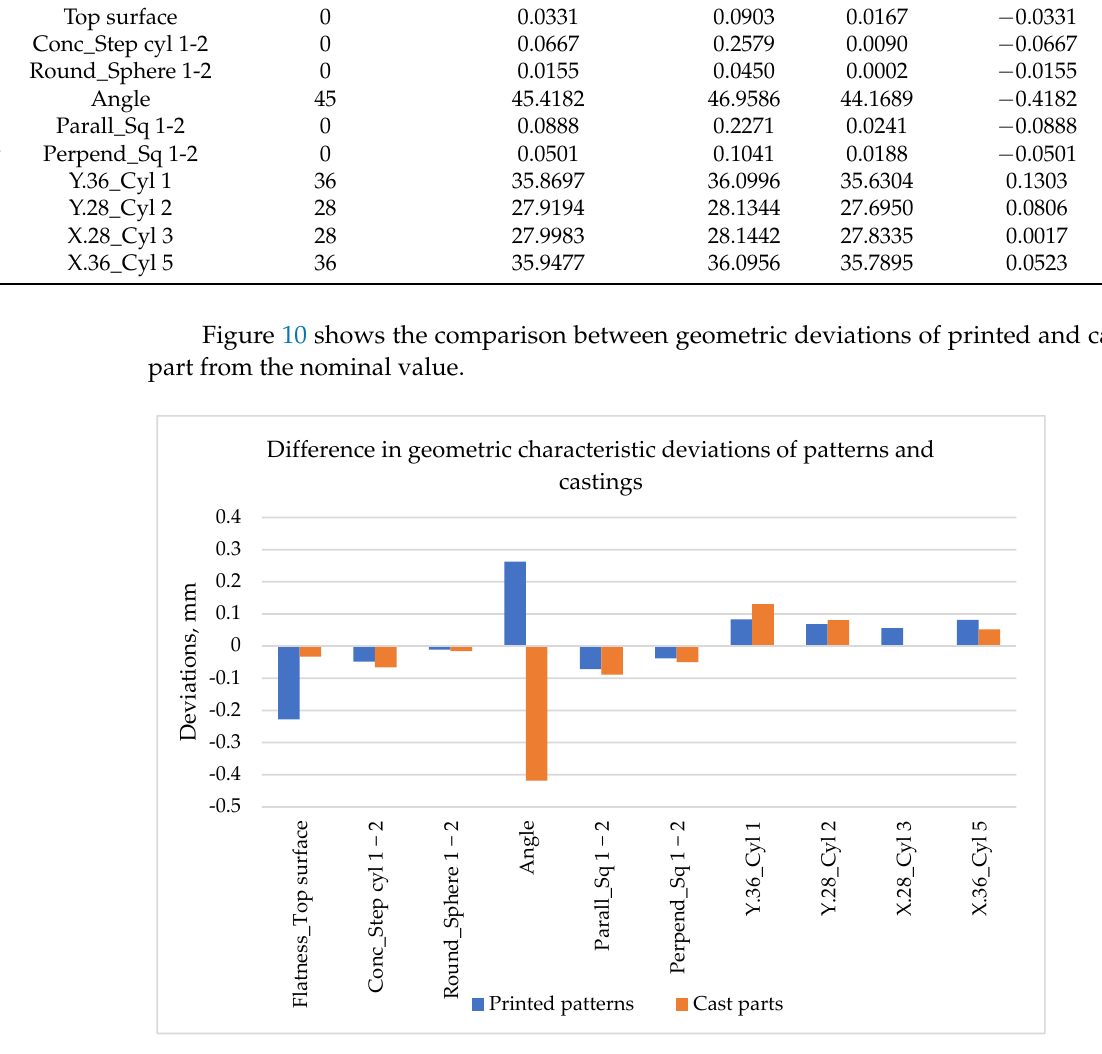
Figure 10. Comparison of Geometric characteristics deviations from the nominal value for patterns and castings.